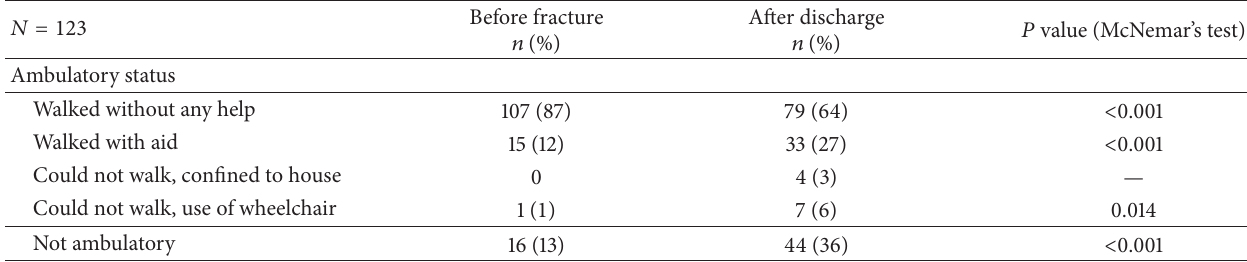
Table 5: Mobility status, prefracture, and posthospital